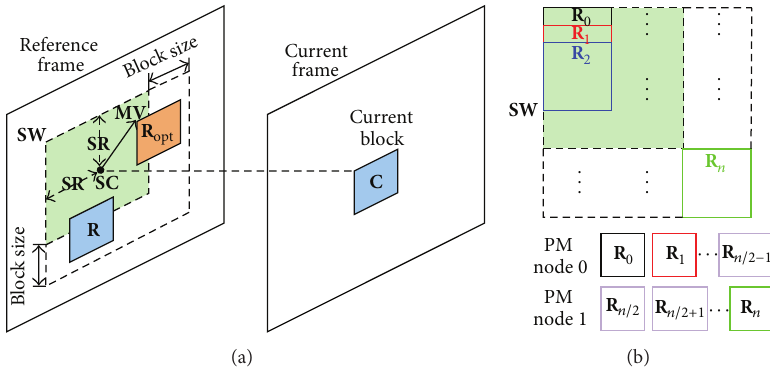
Figure 11: (a) Block Matching Algorithm in Motion Estimation and (b) its